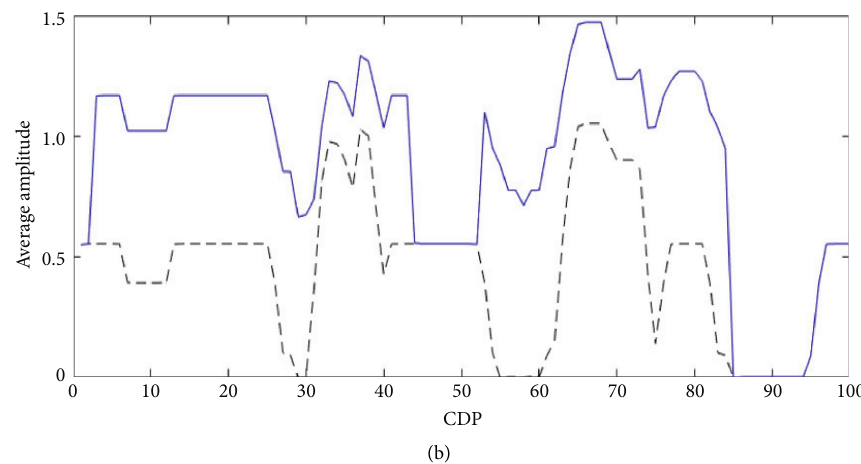
Figure 13: Contrast diagram of the average amplitude extracted from the synthetic seismic records of channel reservoir with and without interference at 40Hz. (a) Noninterference and upper interference. (b) Noninterference and lower interference.